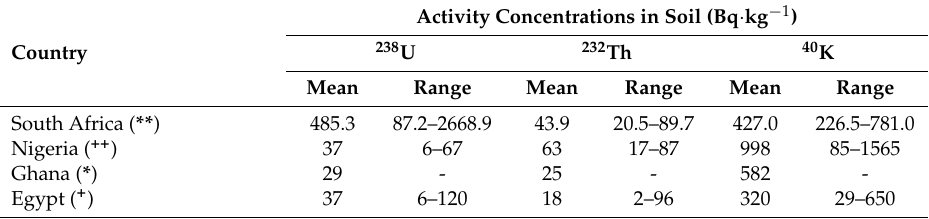
Table 2. Comparison of activity concentrations of 238 U, 232 Th and 40 K in soils from the study area with other